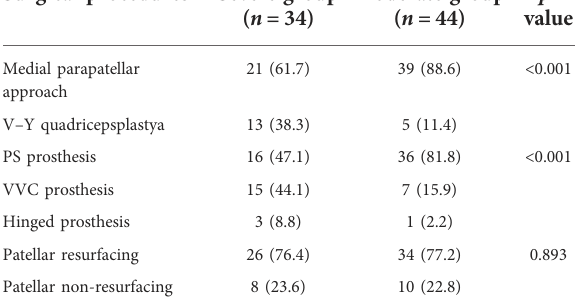
TABLE 2 Surgical